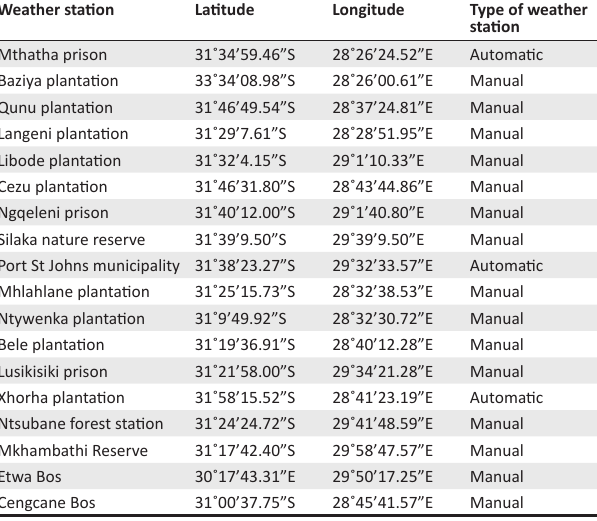
FIGURE 1 : Distribution of weather stations in OR Tambo District Municipality. TABLE 1 : Rainfall weather stations in OR Tambo District Municipality with Global Positioning System (GPS)